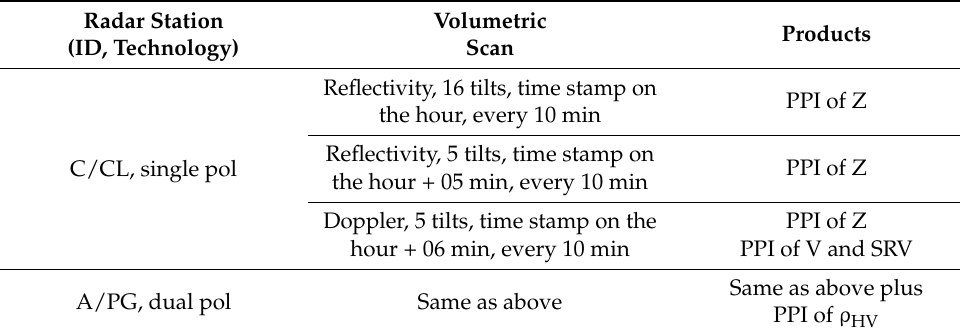
Table 1. Summary of the radar data used in this